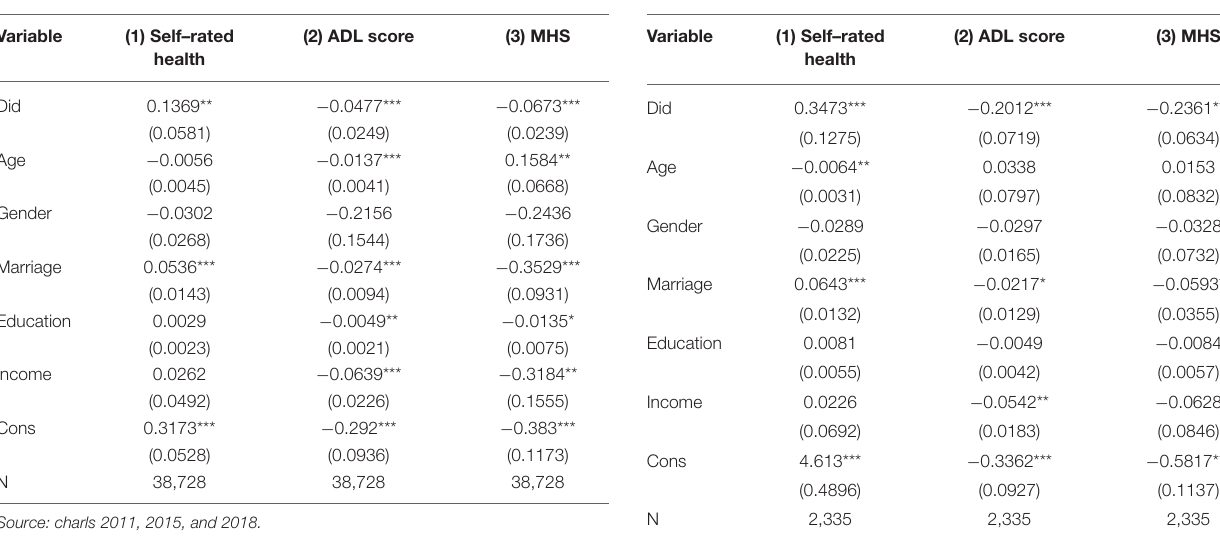
TABLE 7 | DID regression results of the health status.